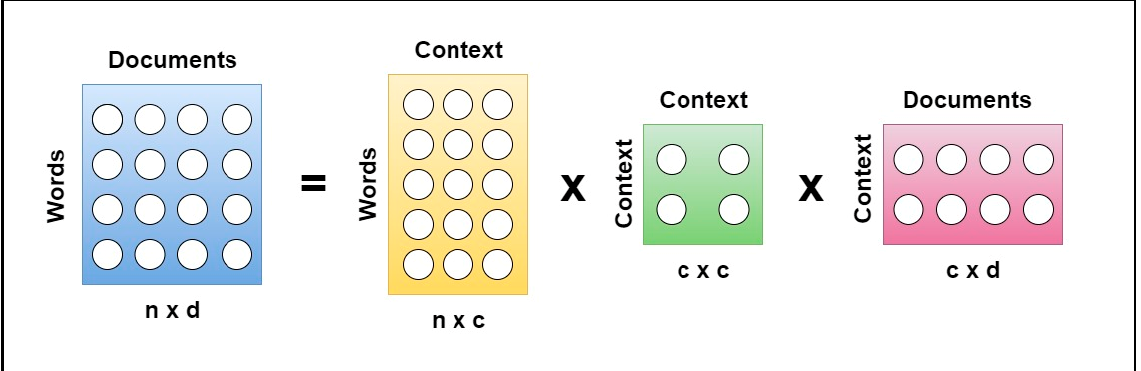
Figure 11. Graphical model illustration for LSA.